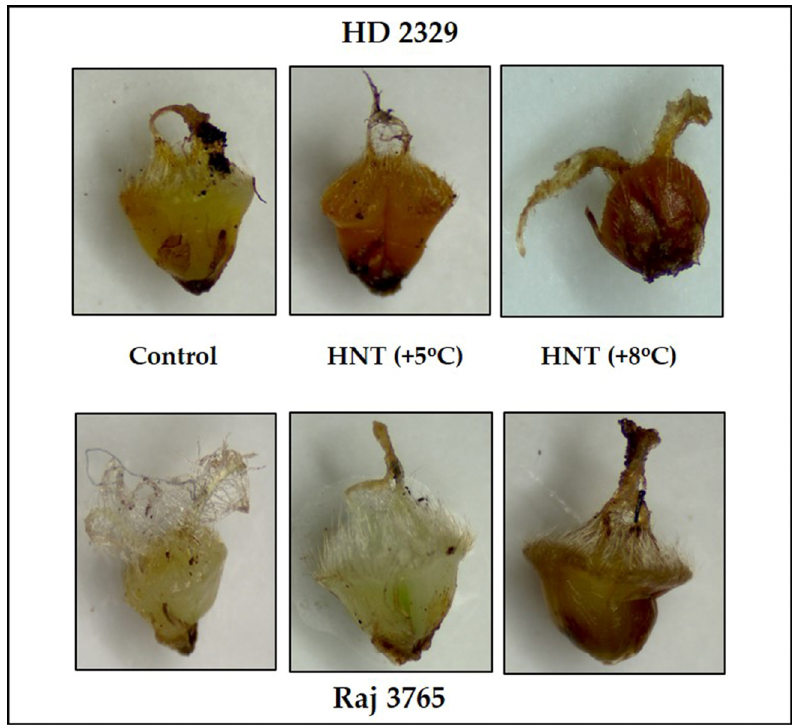
Figure 5. Photomicrographs showing hydrogen peroxide (DAB staining) of pistil in HD 2329 (sensitive) and Raj 3765 (tolerant) at control, HNT (+5 °C) and HNT (+8 °C) treatments.